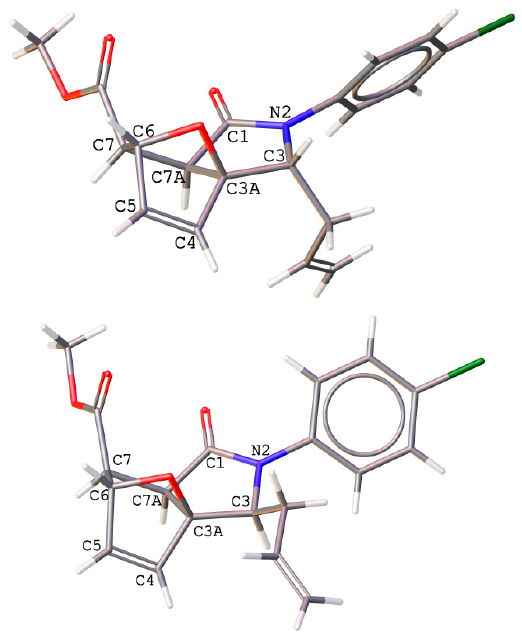
Figure 3. X-ray crystal structures of trans - 6eA (at the top) and cis - 6eB (at the bottom) methyl 3-allyl-2-(4-chlorophenyl)-1-oxo-1,2,3,6,7,7a-hexahydro-3a,6-epoxyisoindole-7-carboxylates.